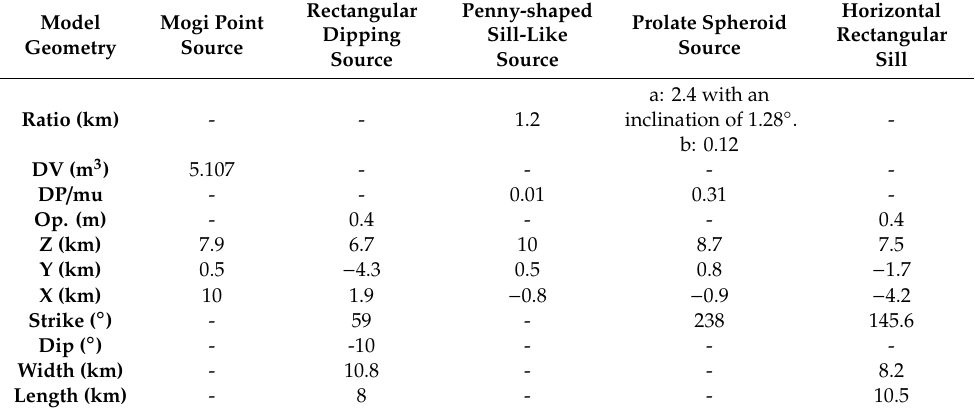
Table A1. Inversion results for the tried geometries. R: ratio, a and b correspond to the major and minor semi-axes of the prolate spheroid; DV: volume change; DP / mu = dimensionless excess pressure (pressure change / shear modulus); Op.: opening of dislocation plane; Z: depth of one edge of rectangular source in meters (positive downwards); The coordinates X and Y have the coordinate system centered in the geographic position ( − 70.42 ◦ − 36.62 ◦ ); Strike: angle of horizontal edge with respect to North (0 ◦ / 360 ◦ = N; 90 ◦ = E; 180 ◦ = S; 270 ◦ = W); Dip: angle with respect to horizontal (0 ◦ = horizontal; − 90 ◦ or 90 ◦ = vertical); Width: second dimension of rectangular source, and finally Length: first dimension of rectangular